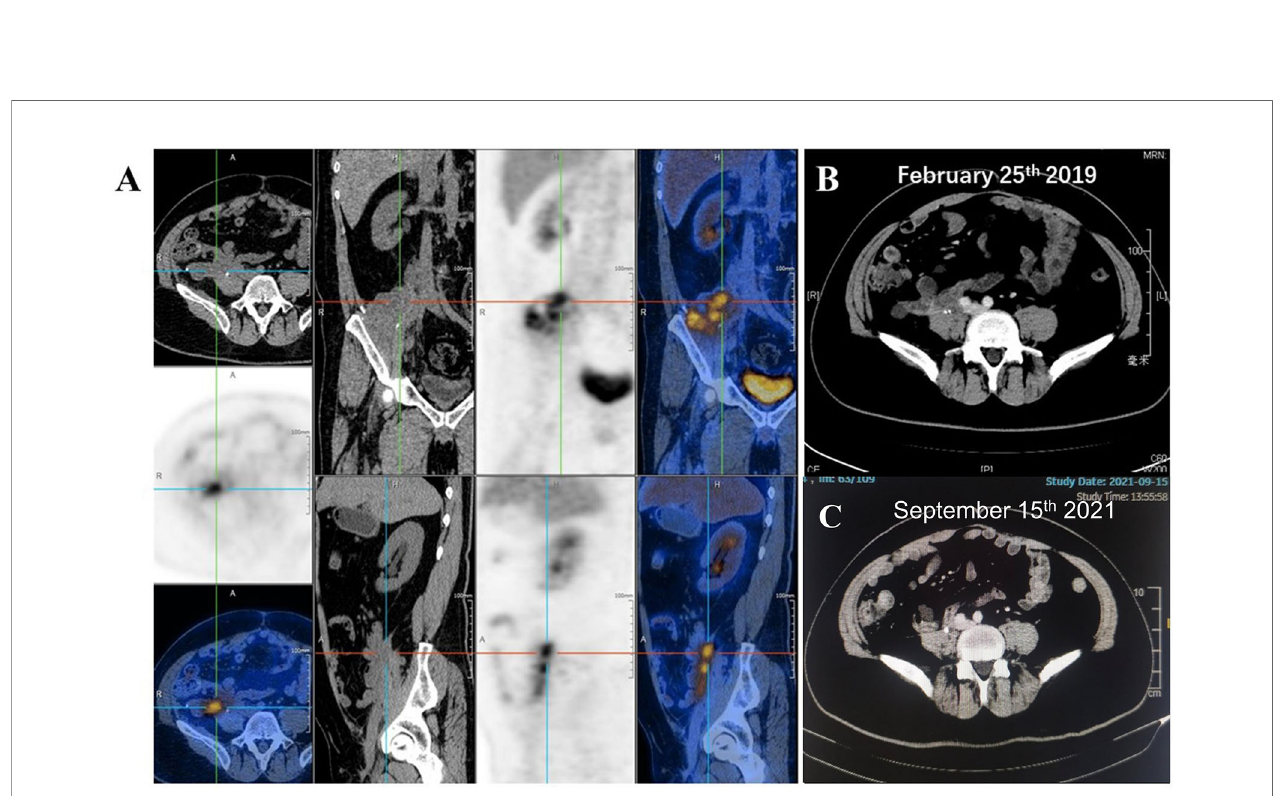
FIGURE 5 | (A) Positron emission tomography/computed tomography (PET/CT) suggested a high local metabolic activity during the follow-up of March 2019. CT scans for the patient on (B) February 25 and (C) September 15,